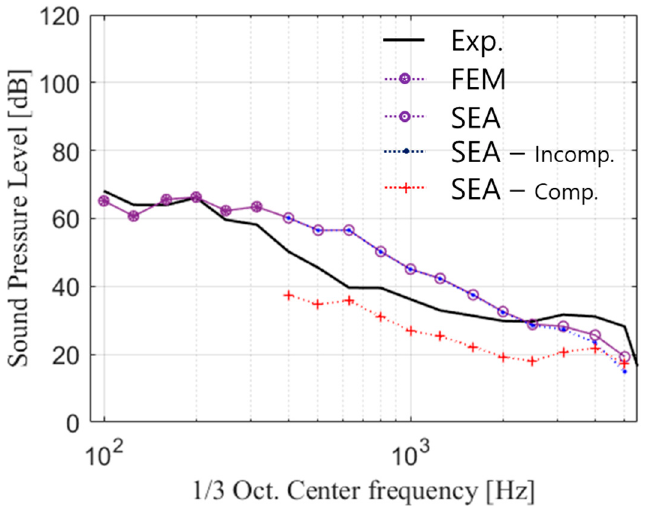
Figure 22. Comparison of numerical and measured interior noise levels using the injected power formula of Equation (60).